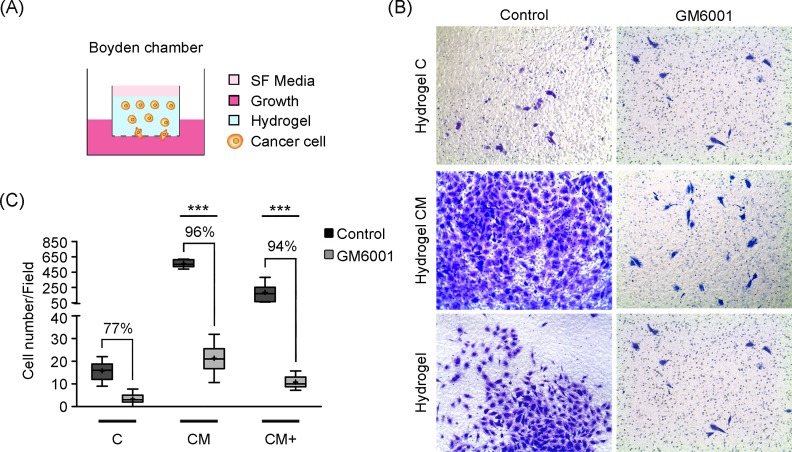
Cell invasion assays within Boyden chambers.Boyden invasion assays in control experiments and with GM6001 MMP-blocking treatment. (A) Diagram of the Boyden invasion assay. Cells migrate through the hydrogel and pores of the transwell membrane in response to 20% FBS cell culture medium. (B) Representative images used to quantify cell invasion. (C) Box-plot of the number of invading cells in control and GM6001 invasion experiments. *** Indicates highly statistically significant difference between groups (p<0.001). (Number of images, n = 20).